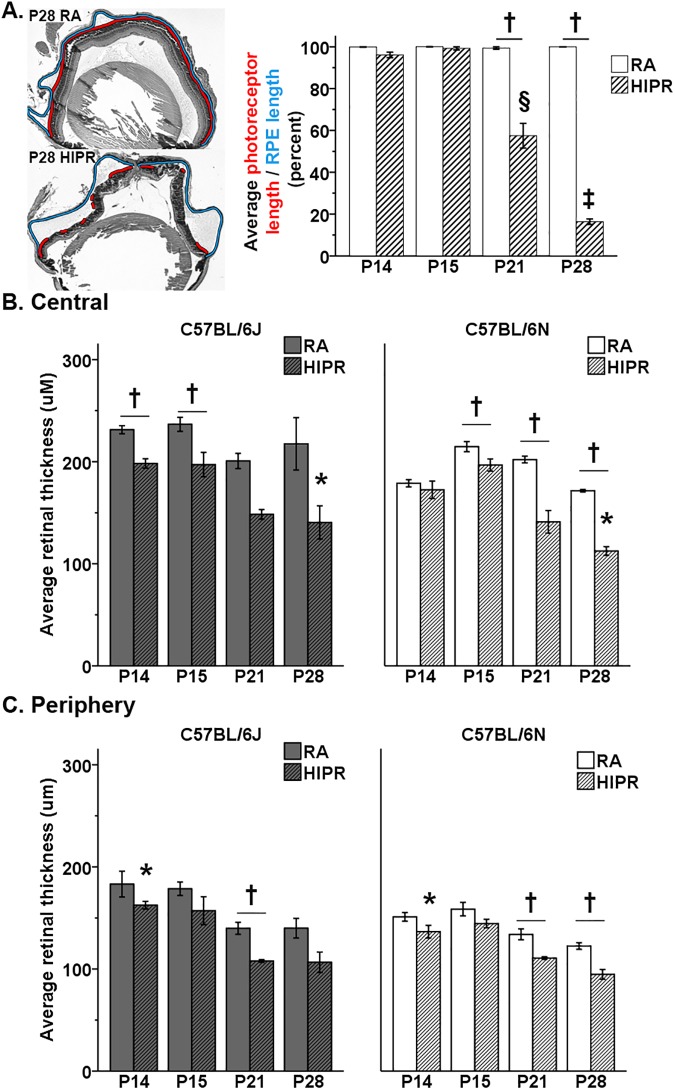
Loss of photoreceptors and retinal thinning are observed in the central and peripheral retina in both strains under hyperoxia-induced proliferative retinopathy (HIPR).(A) On the left, an example measurement of the length of intact photoreceptors (red) was normalized to the length of the retinal pigment epithelium (RPE, blue). Loss of photoreceptor orientation was only visible in C57BL/6N mice. (B, C) Retinal cross sections were measured at 100 μm on either sides of the optic nerve and in the retinal periphery. (B) Near the optic nerve, HIPR C57BL/6N had significantly thinner retinas at P15, P21, and P28 than their room air (RA) controls. (C) In the peripheral retina, HIPR C57BL/6N had significantly thinner retinas at P21 and P28 compared to room air controls. † p<0.05 HIPR to respective age-matched RA controls. § p<0.05 P21 HIPR C57BL/6N compared to P15 HIPR C57BL/6N. ‡ p<0.05 P28 HIPR C57BL/6N compared to P21 HIPR C57BL/6N. * p<0.05 HIPR C57BL/6J compared to HIPR C57BL/6N. Values were mean ± SEM (N = 3–4).